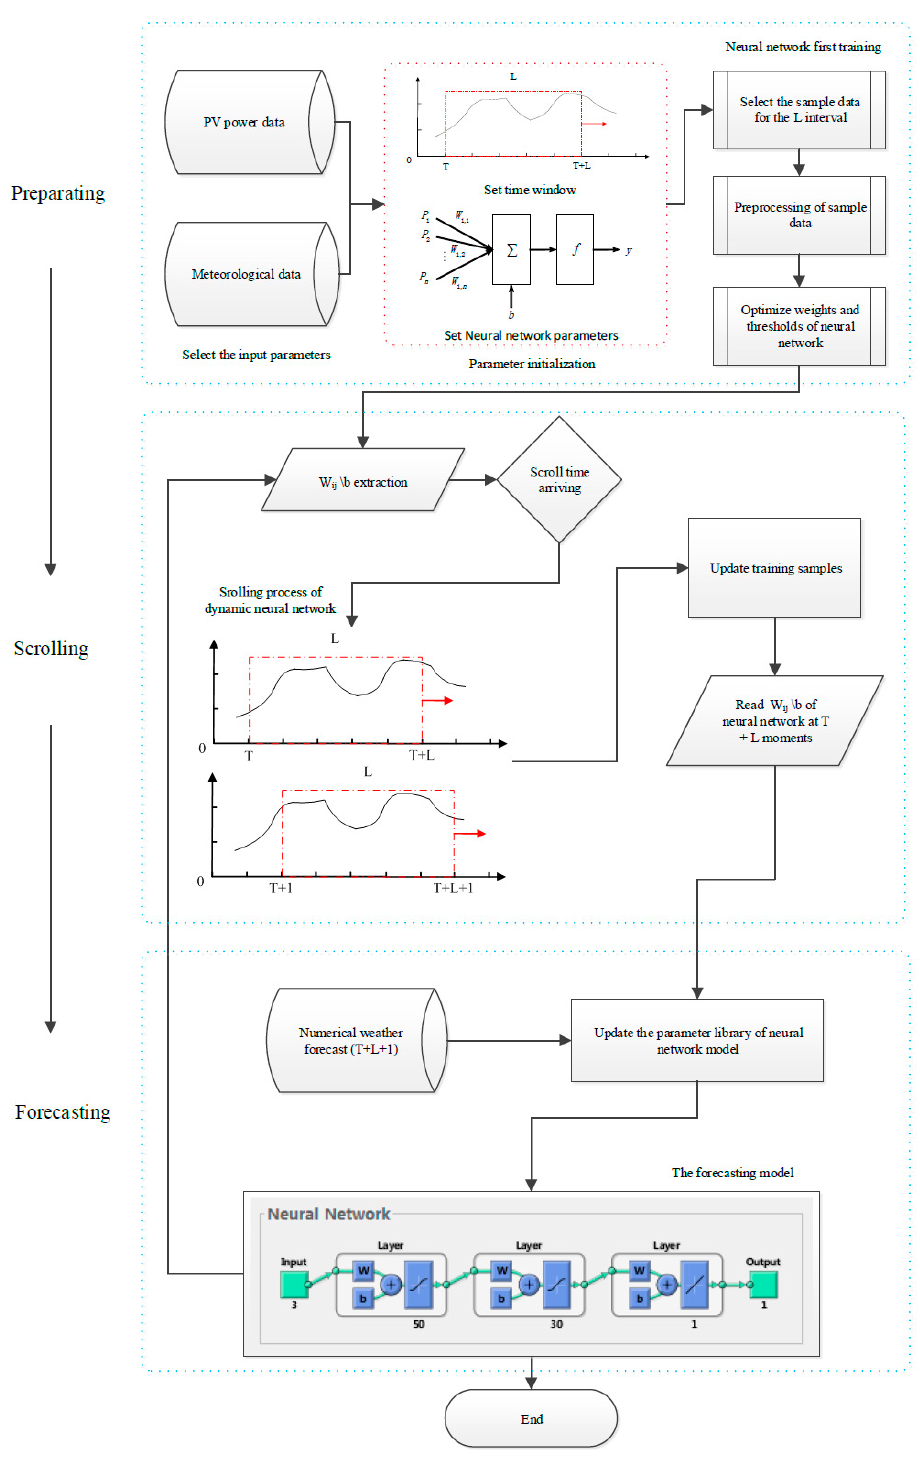
Figure 8. Modeling flow diagram of the dynamic neural network based on scrolling time window technology.